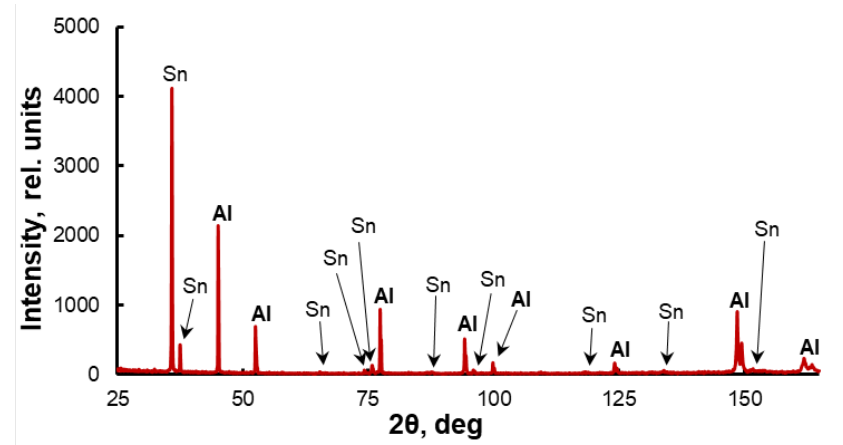
Figure 3. X-ray diffraction pattern of sintered Al-30Sn alloy.